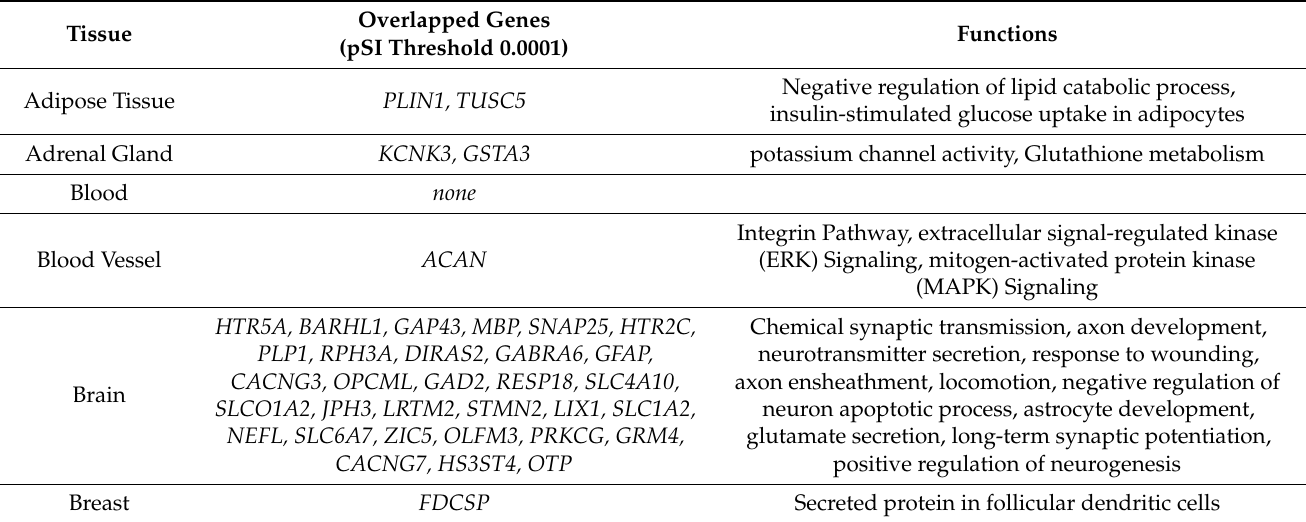
Table 1. List of tissue-specific (pSI < 0.0001) genes and their